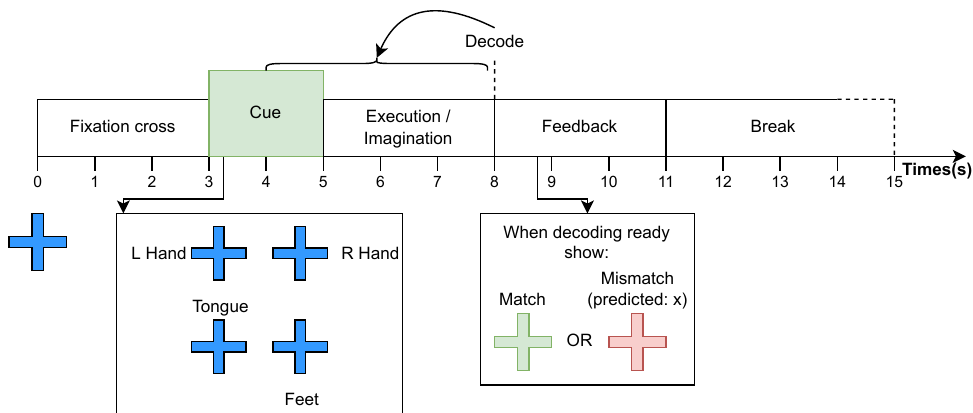
Figure 2. One trial in a feedback run of the data acquisition procedure. The procedure for feedback runs was the same as calibration, with the addition of feedback after the MI phase. Including the time to decode, the feedback phase lasted 3 s. In addition to textual feedback, the fixation cross turned green on a match and red on a mismatch. The feedback decoding model used a sliding window of 2.5 s, starting 1 s before the GO signal and ending after the first 3 s of movement imagination, with strides of 0.25 s. This resulted in 7 overlapping windows for which a prediction was made. To obtain a match, the majority of windows should predict the requested